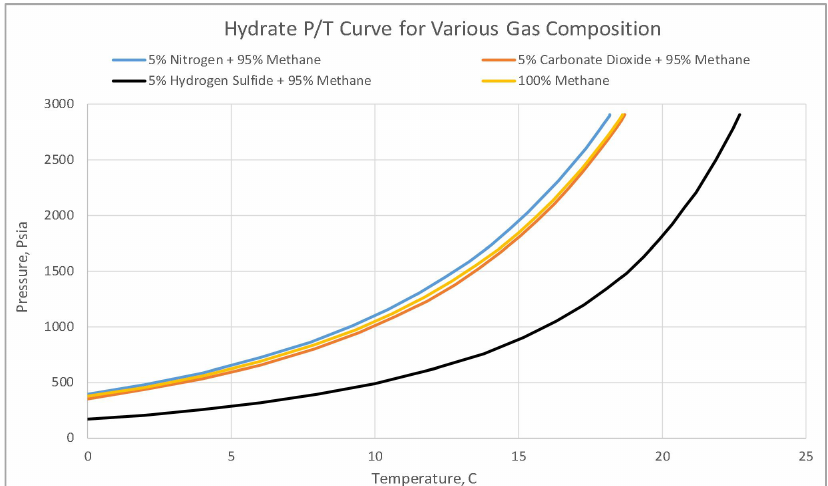
Figure 8—Hydrate formation curve for various gas composition without MEG